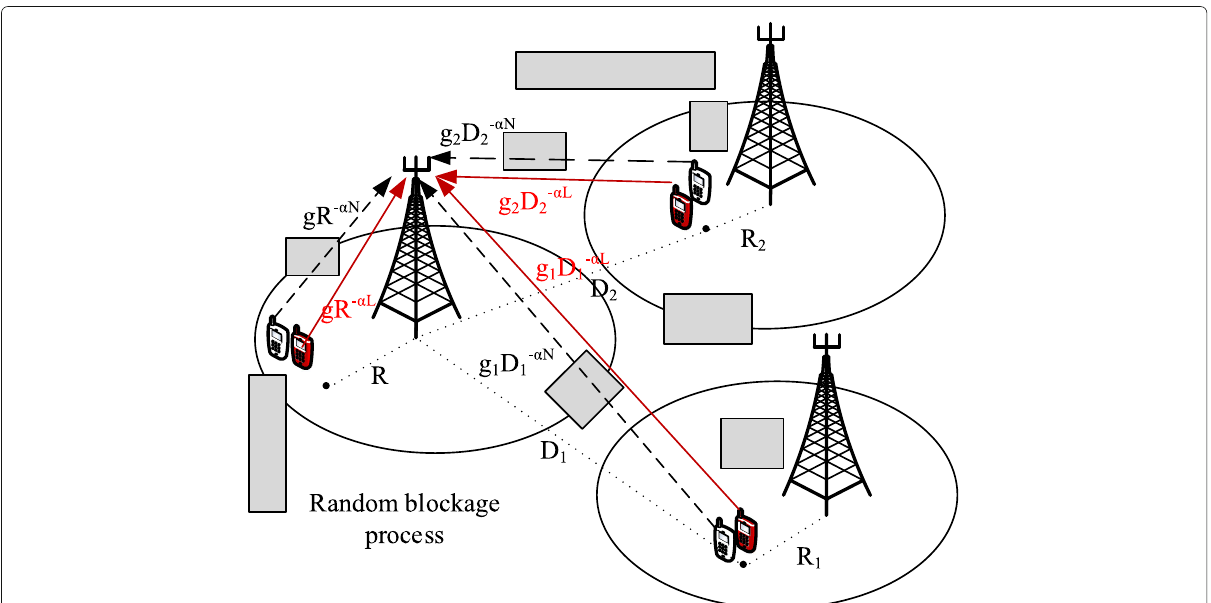
Fig. 1 Visual representation of the uplink of mmWave cellular networks, focusing on the serving user and two interfering users in adjacent cells. Blockages are modeled as random process of rectangles as in [11]. White and red color marked users denotes the LOS and NLOS representation of the same